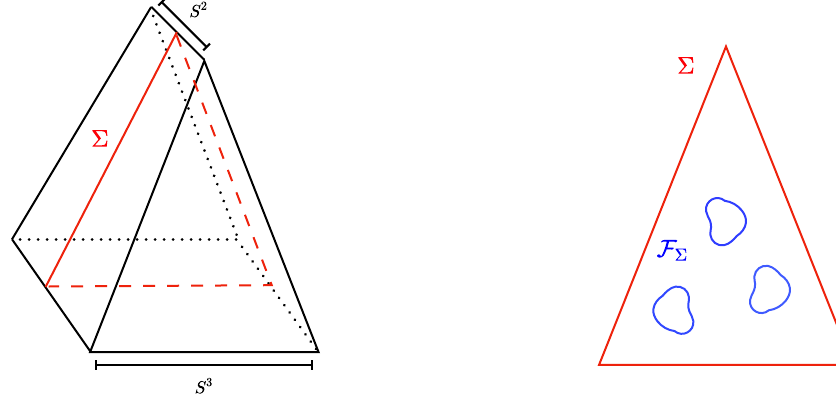
Figure 3 . The left figure shows the codimension-1 slice Σ of the resolved conifold where a QFT state would be defined. In the closed string theory, the analogue of a time slice is a set F Σ of loops configurations associated with Σ . For the A-model string, we will restrict these loop configurations to lie in a Lagrangian submanifold L ⊂ Σ . The string wavefunctional assigns an amplitude to each configuration of such